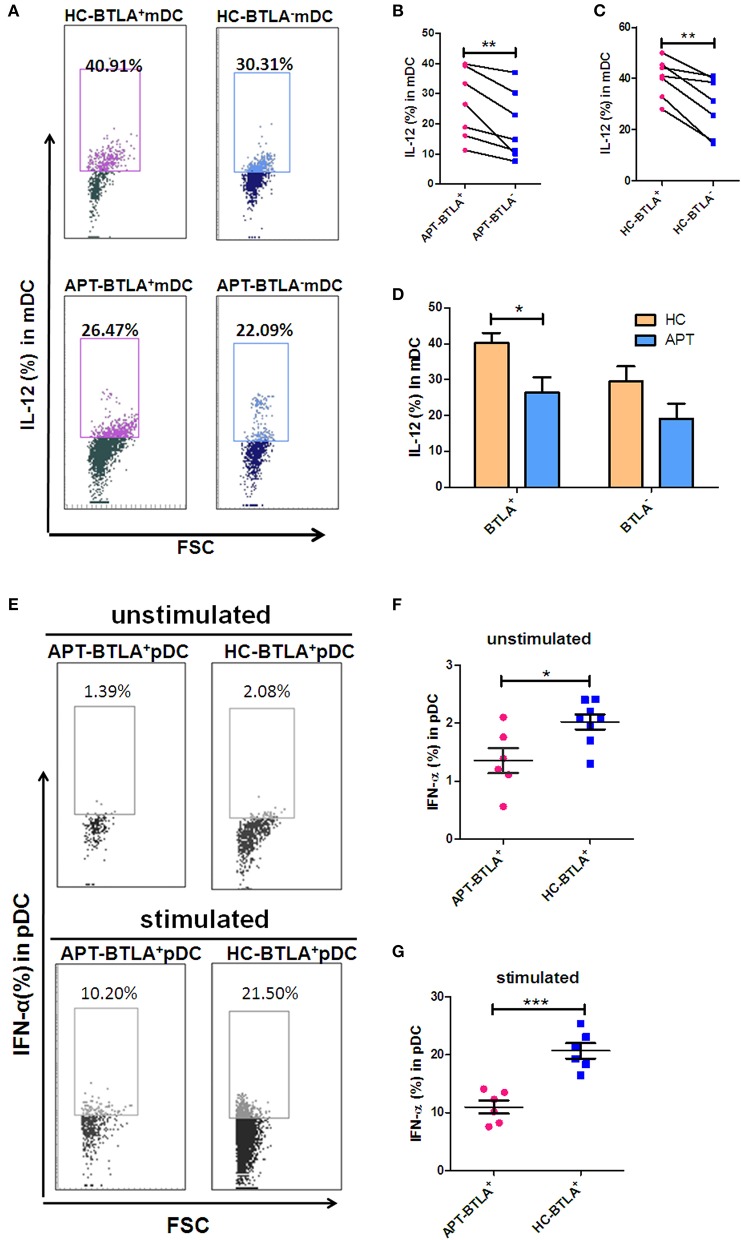
BTLA+ DCs in active TB showed a decreased production of IL-12 and IFN-α compared to those in HCs. As IL-12 is the dominant cytokine-inducing Th1 differentiation produced by mDCs, meanwhile IFN-α is the dominant cytokine produced by pDCs, we sought to investigate whether BTLA expression affects IL-12 and IFN-α production in mDC and pDC subsets, respectively. (A) Representative histograms for intracellular cytokine staining by flow cytometry analysis of IL-12 produced in BTLA+ or BTLA− mDCs. (B,C) show the mean frequencies of IL-12-producing mDCs in BTLA+ DCs and BTLA− DCs from APT patients (n = 6) and HCs (n = 6), respectively. (D) shows IL-12-producing mDCs in BTLA+ DCs and BTLA− mDCs between HC and APT patients. (E) Representative histograms for intracellular cytokine staining by flow cytometry analysis of IFN-α produced in BTLA+ pDCs. (F,G) show the IFN-α-producing pDCs in BTLA+ pDCs between HCs (n = 6) and APT patients (n = 6). The P-values are shown in each column (ANOVA with the Bonferroni post-hoc test). *P < 0.05, **P < 0.01, ***P < 0.001.